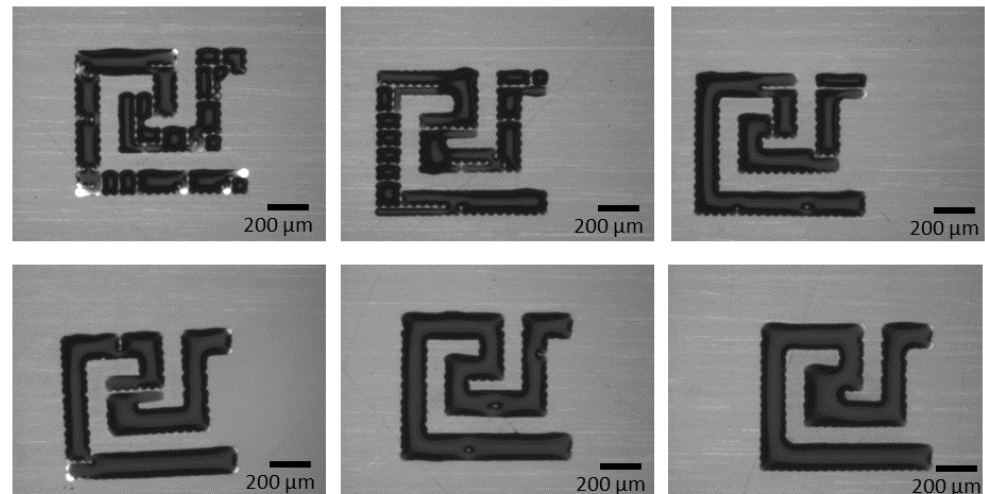
Figure 6. Stages of Substrate Activation Using UV Ozone Cleaning System (Osilla).